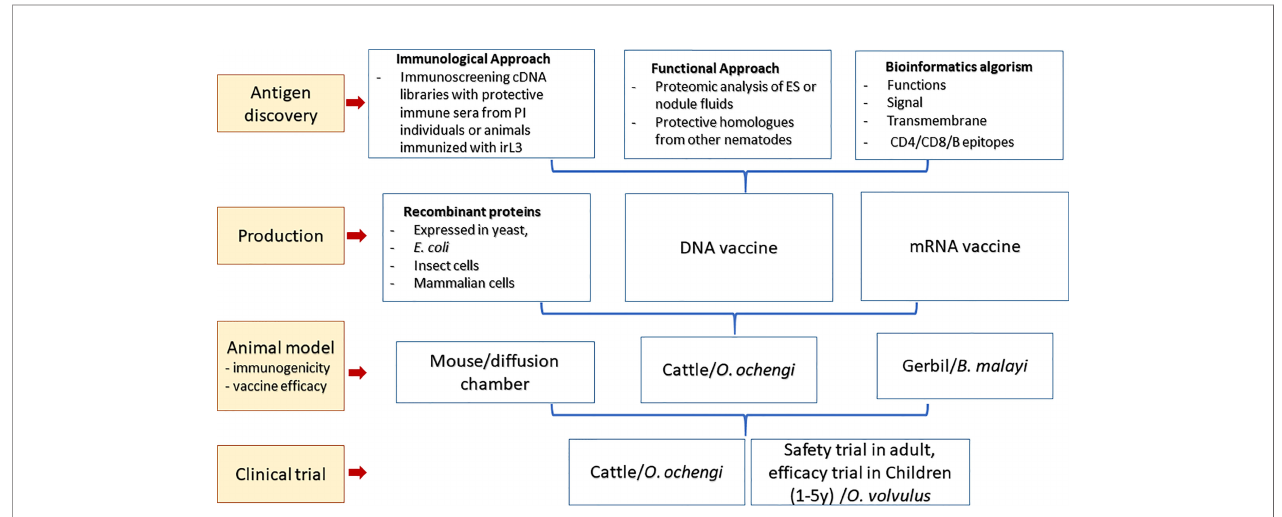
FIGURE 2 | The roadmap to making vaccine against human